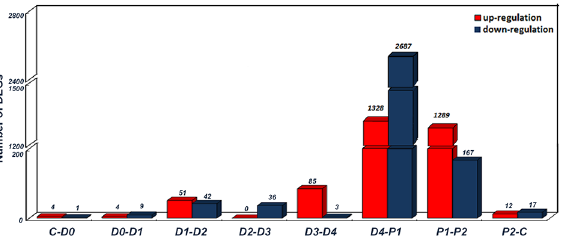
Fig 2. Differentially expressed genes (DEGs) detected between eight comparisons of adjacent molting stages (C-D0, D0-D1, D1-D2, D2-D3, D3-D4, D4-P1, P1-P2, and P2-C). The number of up- regulated and down-regulated genes between comparisons is given. The x-axis indicates adjacent stages in comparisons. The y-axis indicates the number of DEGs.